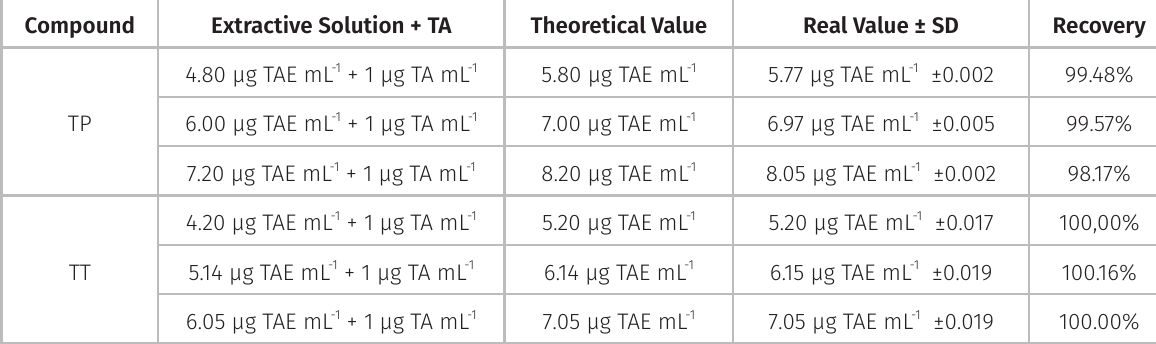
Table V. Recovery results. Compound Extractive Solution +